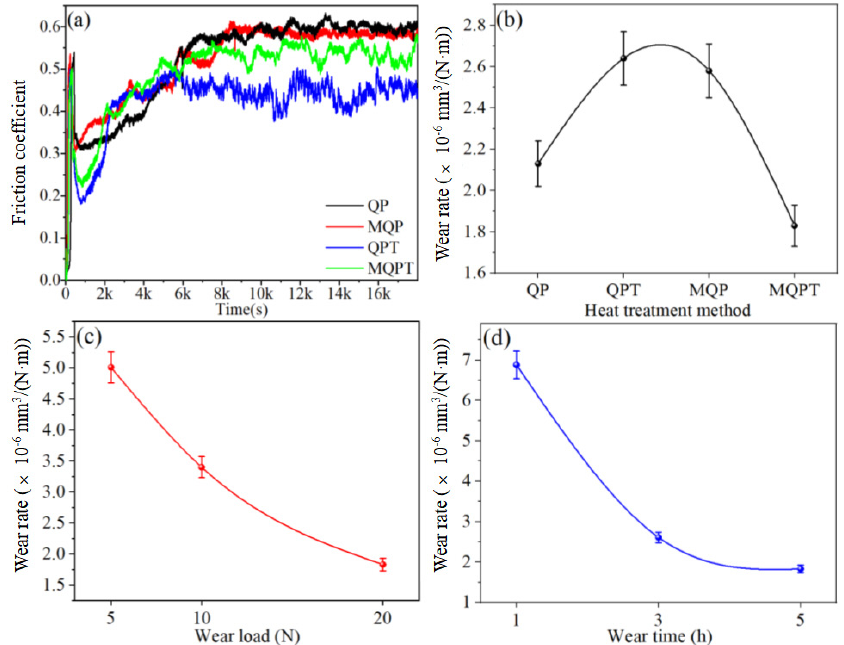
Figure 5. Friction coefficient, microhardness and tensile strength of the VCFC with different heat- treated processes. ( a ) The friction coefficient; ( b ) Wear rate of four specimens under wear load 20 N and wear time 5 h; ( c ) Wear rate of MQPT specimen under wear time 5 h and different wear load; ( d ) Wear rate of MQPT specimen under wear load 20 N and different wear time.